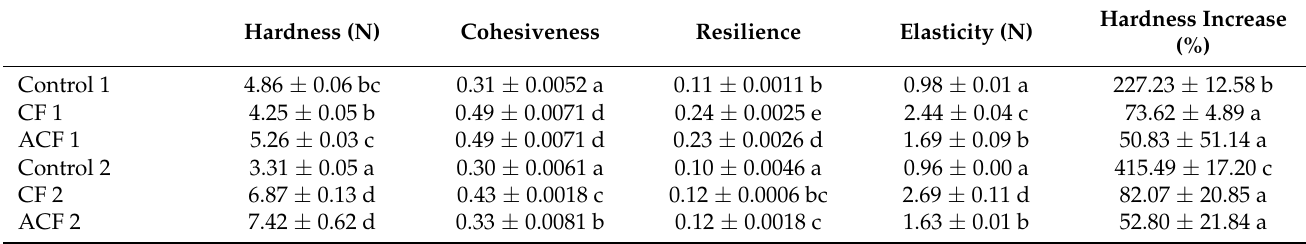
Table 4. Textural parameters of gluten-free breads with or without